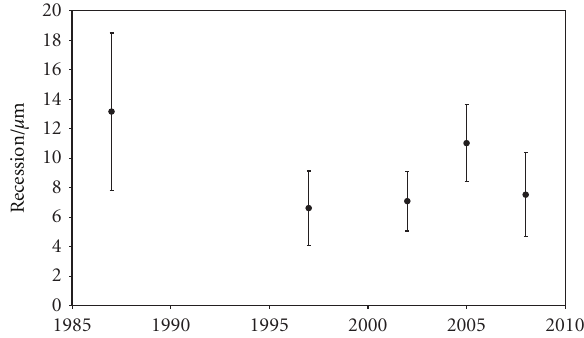
Figure 3: Averages and ranges (standard deviations) of limestone surface recession at ICP Materials test sites (one year exposures).